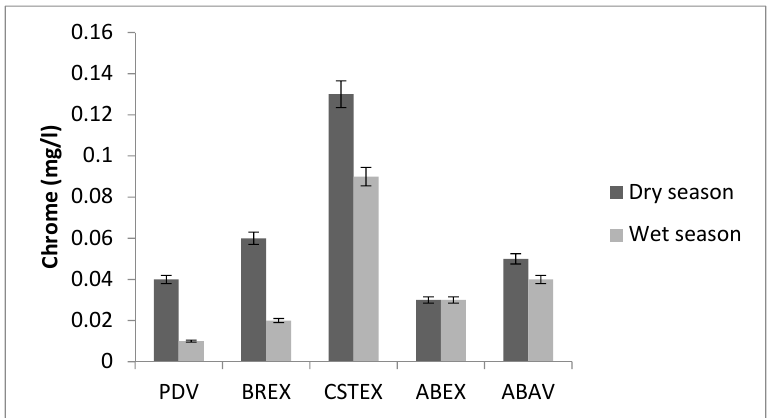
Figure 6. Chromium concentration.